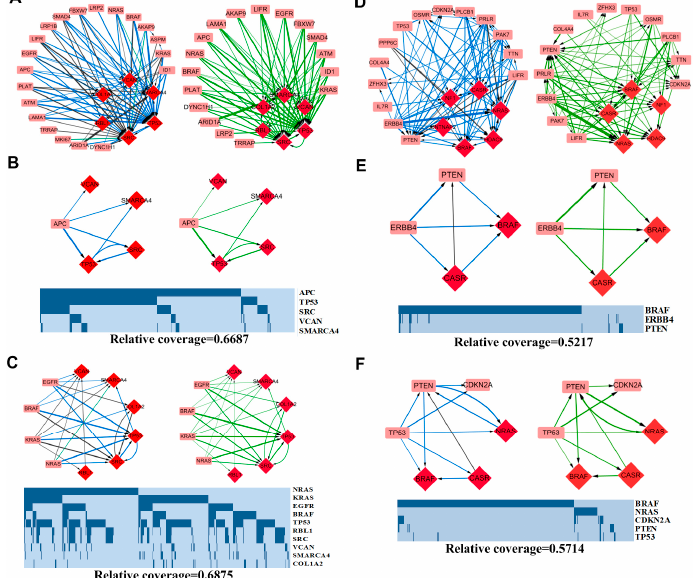
Figure 6. Fitness networks of the top mutated genes in FN.com (red diamond), edges of functional continuity with mean frequencies higher than 0.01, as well as their mutational profiles. Edges of functional continuity, co-occurrence and mutual exclusivity are colored green, dark blue, and light blue, respectively. A thicker edge corresponds to a higher mean frequency. ( A ) Fitness network for COAD. ( B ) APC-related patterns for COAD; ( C ) MAPK pathway-related patterns for COAD; ( D ) Fitness network for SKCM; ( E ) TP53-related patterns for SKCM; ( F ) ERBB4-related patterns for